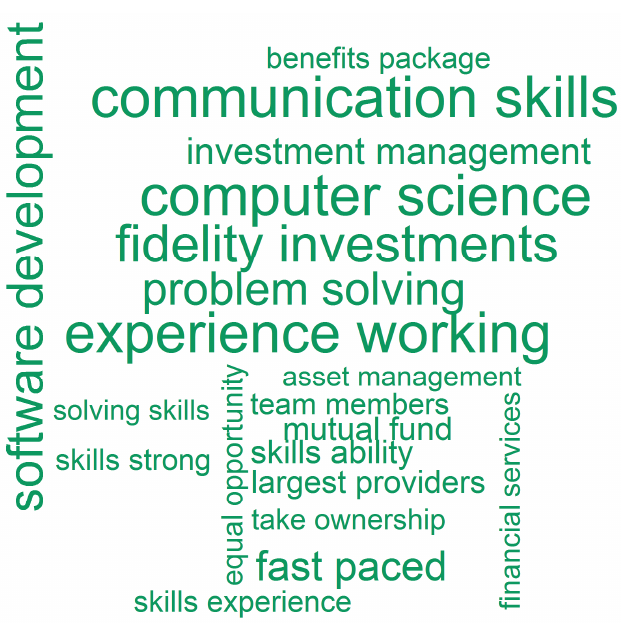
Figure 16. Job Descriptions Visualization—Engineer (unseen